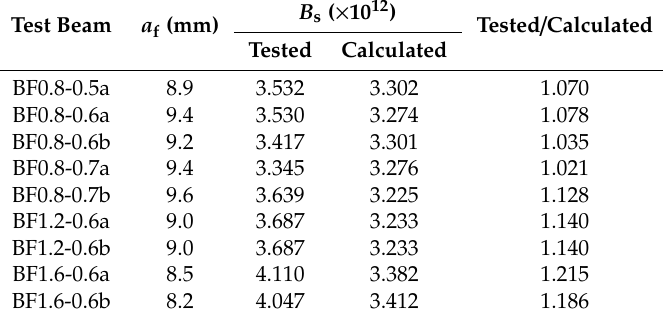
Table 5. The measured sti ff ness of beams under static load and calculated sti ff ness